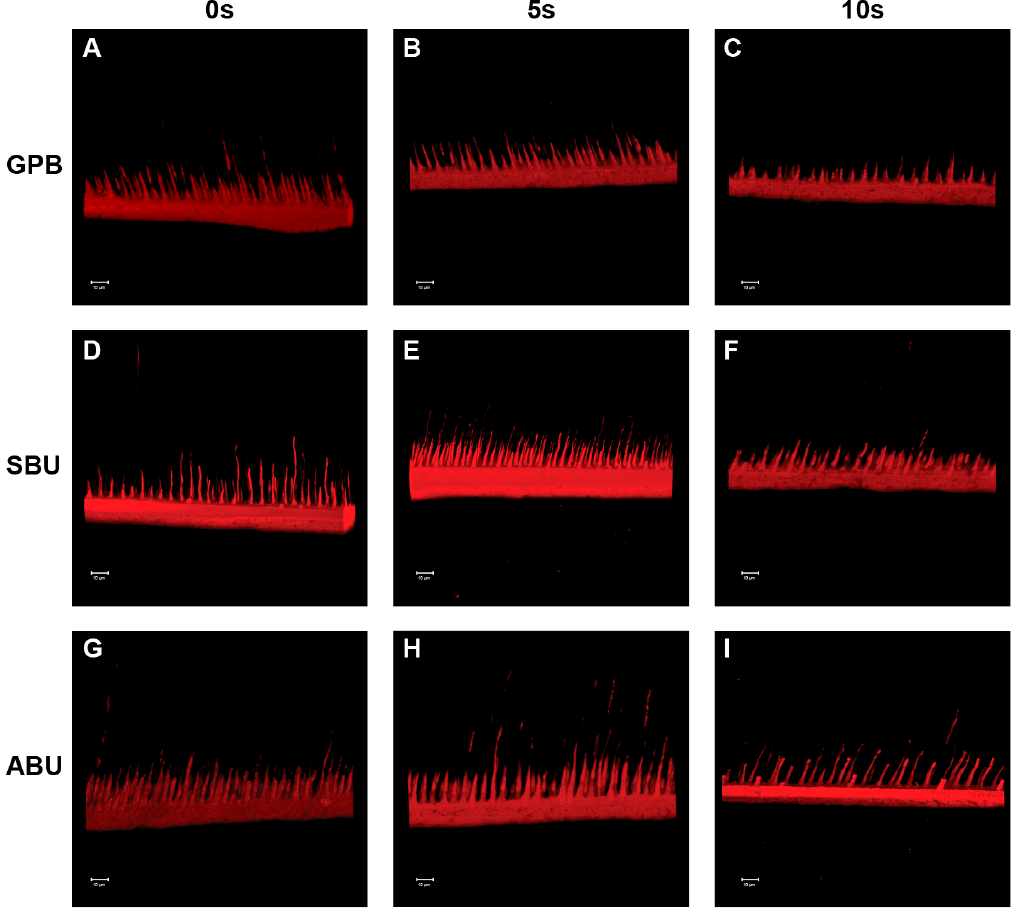
Figure 5. Confocal laser scanning microscopy (CLSM) images of the universal adhesives interfaces in etch-and-rinse mode. ( A – C ) correspond respectively to GB0, GB5, and GB10; ( D – F ) correspond respectively to SB0, SB5, and SB10; ( G – I ) correspond respectively to AB0, AB5, and AB10.